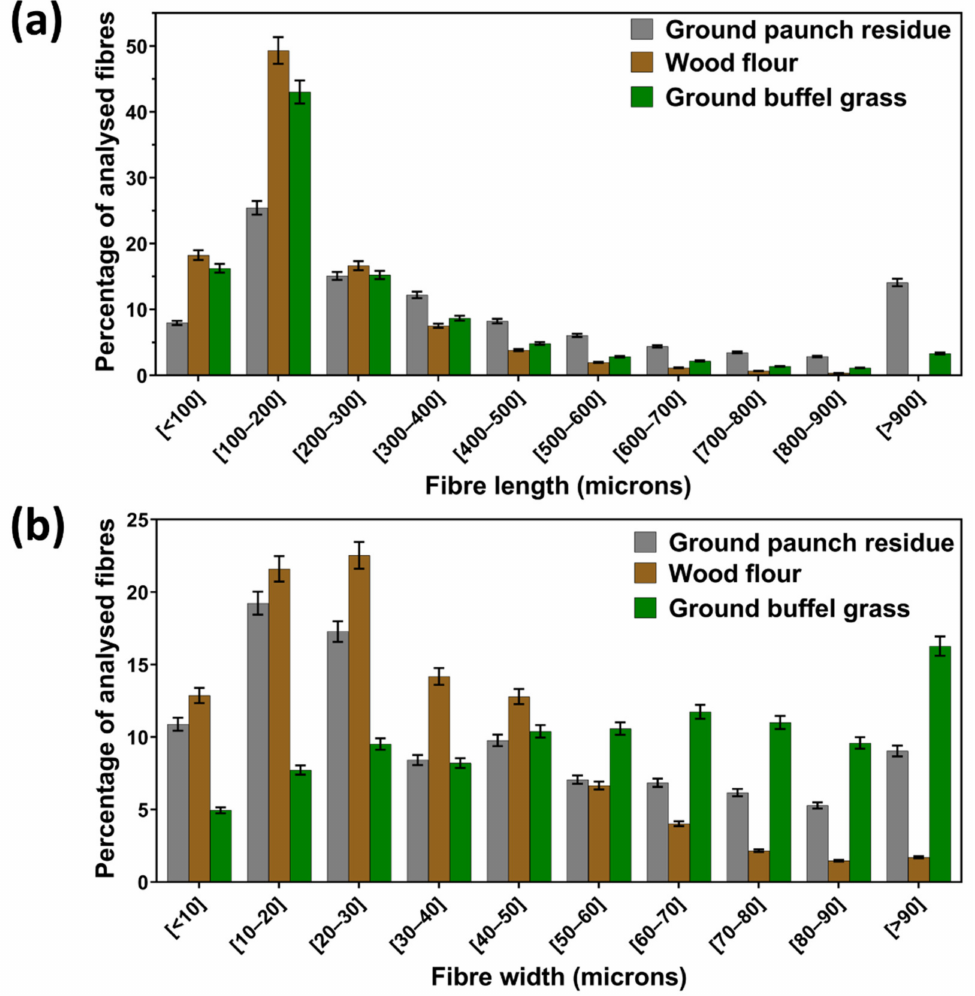
Figure 4. Histograms of the distribution of ( a ) fibre length and ( b ) fibre width of ground paunch (grey), wood flour (brown) and ground buffel grass (green). Average number of fibres analysed: ground paunch = 4100 ± 100, wood flour = 13,100 ± 500 and ground buffel grass = 4200 ± 100. Error bars represent 95% confidence intervals ( n =